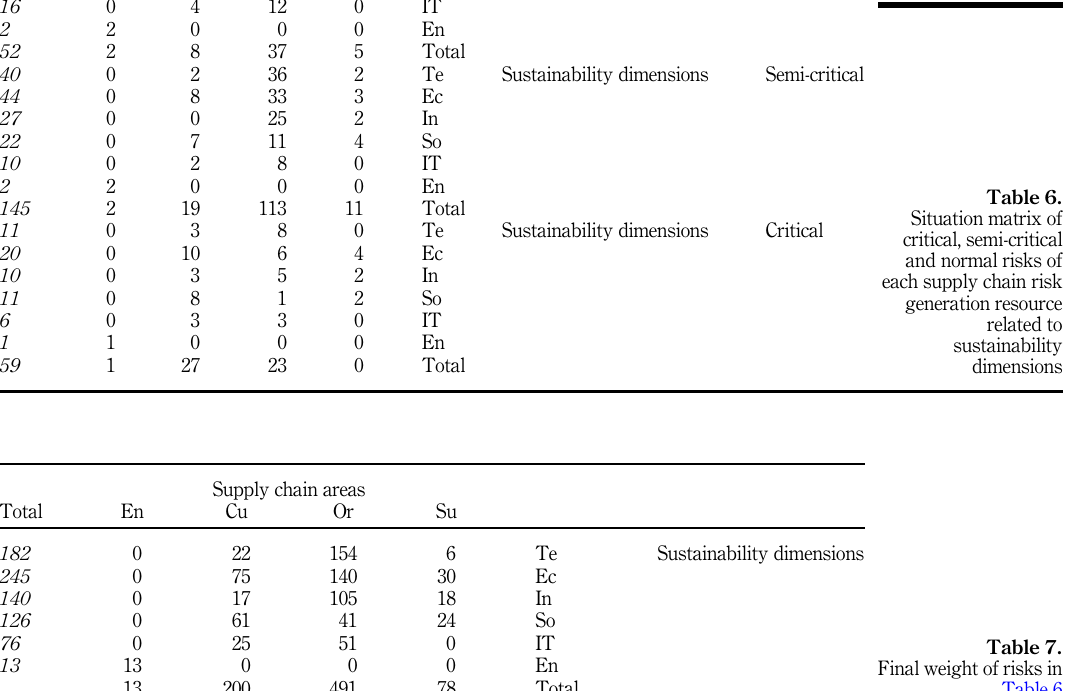
Final weight of risks in